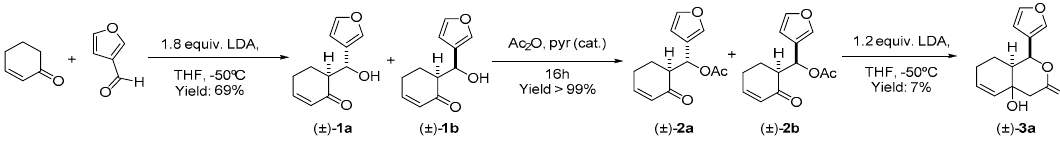
Figure 5. Key n.O.e. correlations for (±)- 3a .